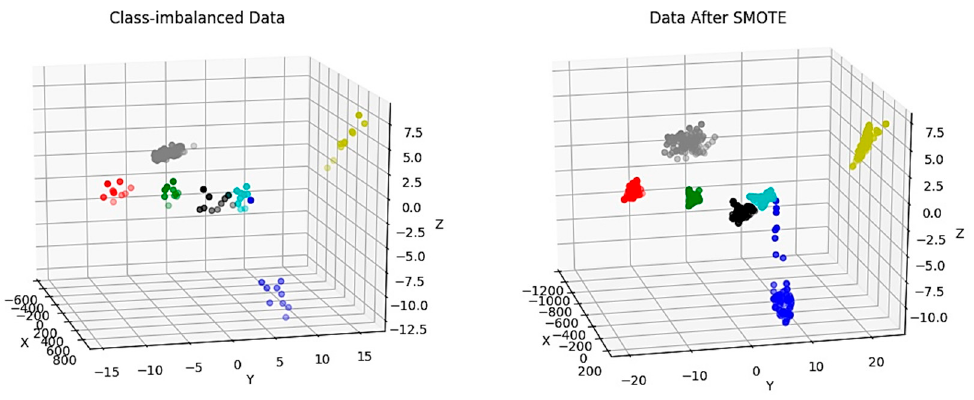
Figure 8. Date of original and resampled.